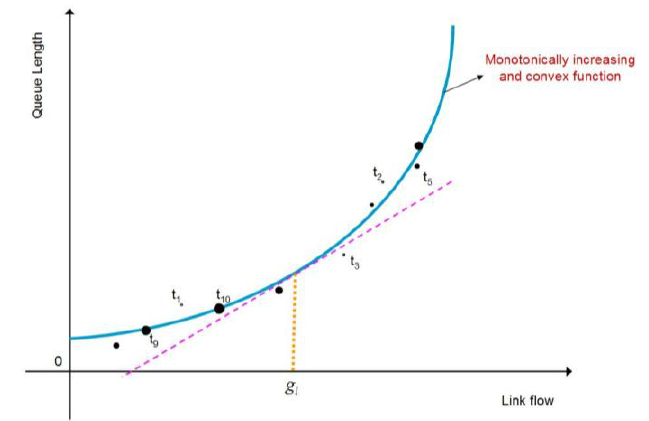
Figure A2. Estimation of the derivative of queue